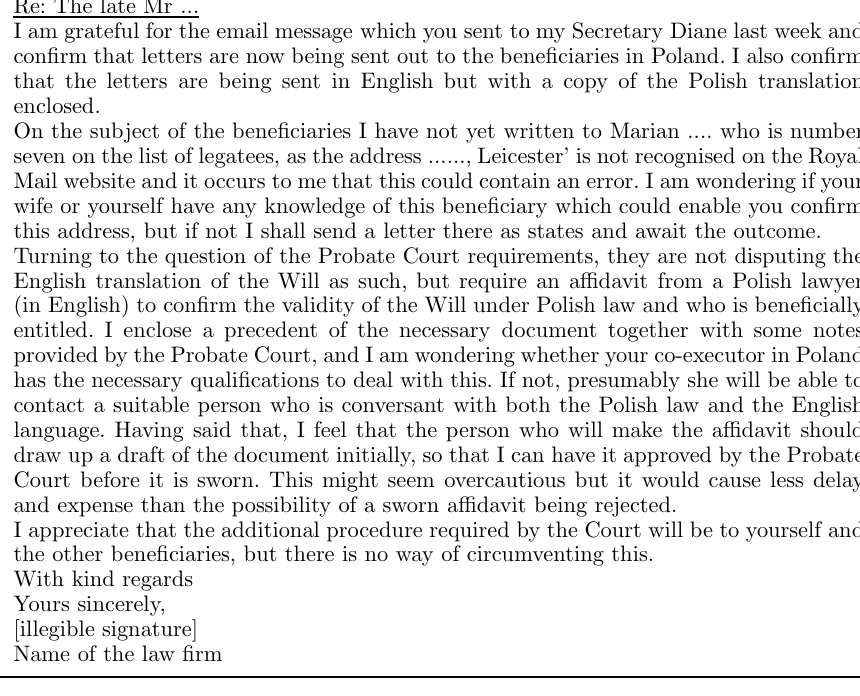
A letter written by the English solicitor with the text